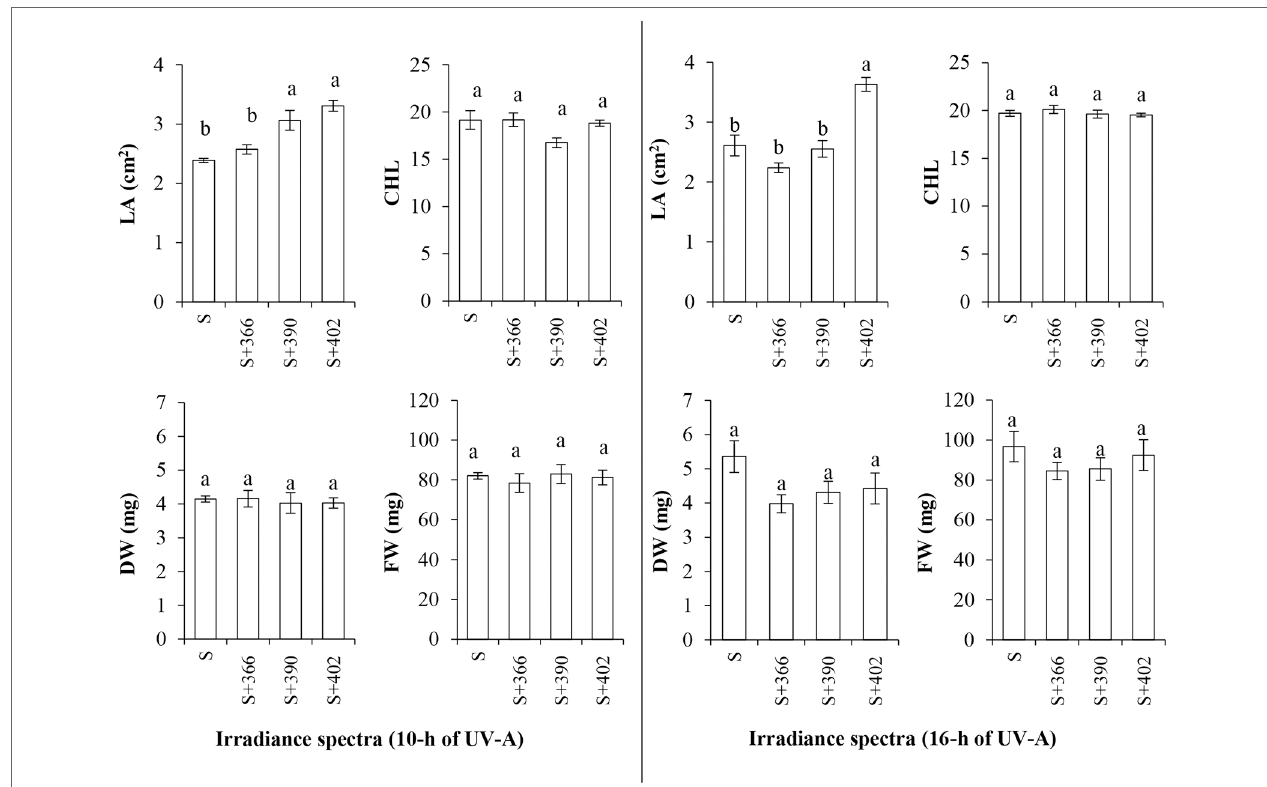
FIGURE 2 | The effect of supplemental UV-A LED radiation on leaf area (LA), chlorophyll index (CHL), dry weight (DW), and fresh weight (FW), of mustard microgreens. S, standard irradiance. Different letter(s) indicates a significant difference at P ≤ 0.05 by the Duncan’s Multiple Range